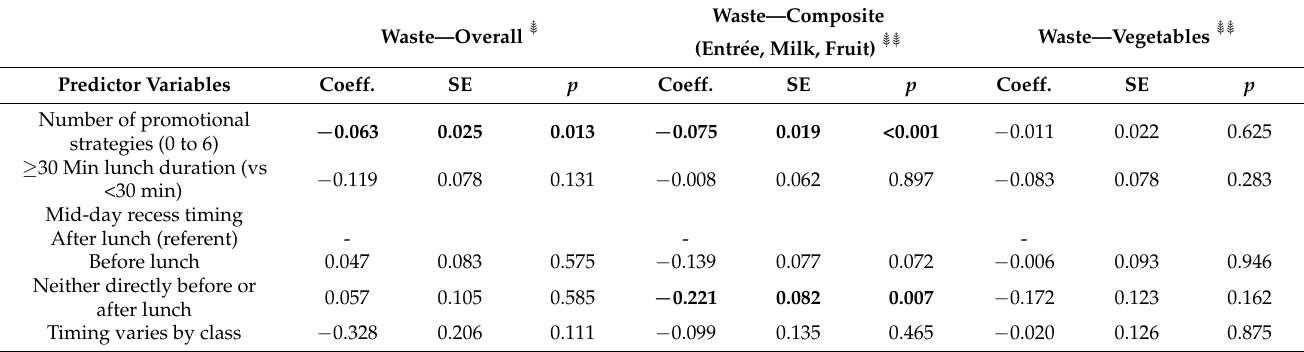
Table 5. Regression models predicting perceived extent of food waste in school lunches. Waste—Composite Waste—Overall ⸙ Waste—Vegetables ⸙⸙ (Entrée, Milk, Fruit) ⸙⸙ Predictor Variables